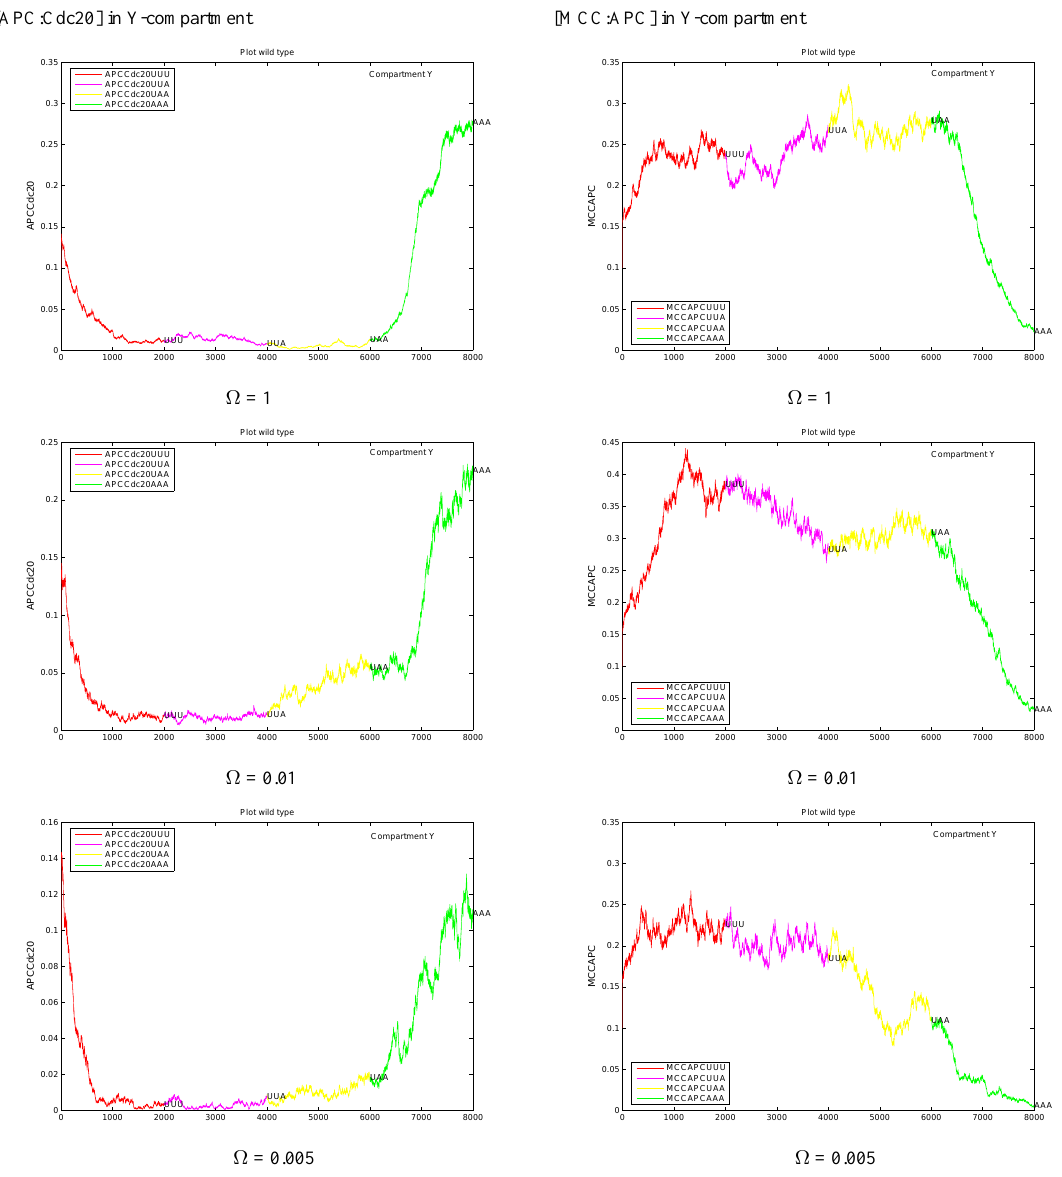
Figure 4: Concentration of APC:Cdc20 (left) and MCC:APC (right) as a function of time (8000 iterations corresponding to 12 min) in the middle compartment Y at noise amplitude N = 10 − 5 . With decreasing diffusion coefficient Ω , dynamics in the phases with one kinetochore unattached (UAA) become more and more distinct, and in some cases a steady state equilibrium is not reached any more within phase simulation time (3